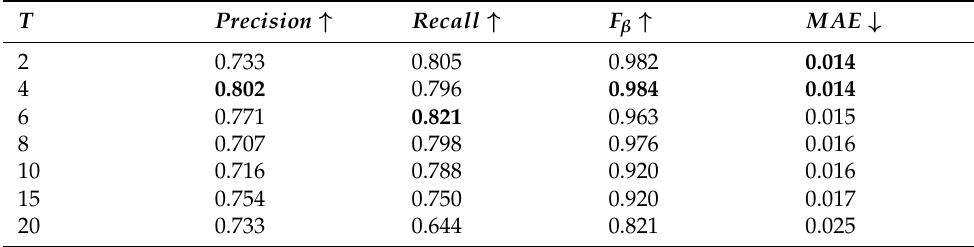
Table 5. The detection performance of SDebrisNet for different hyperparameters T